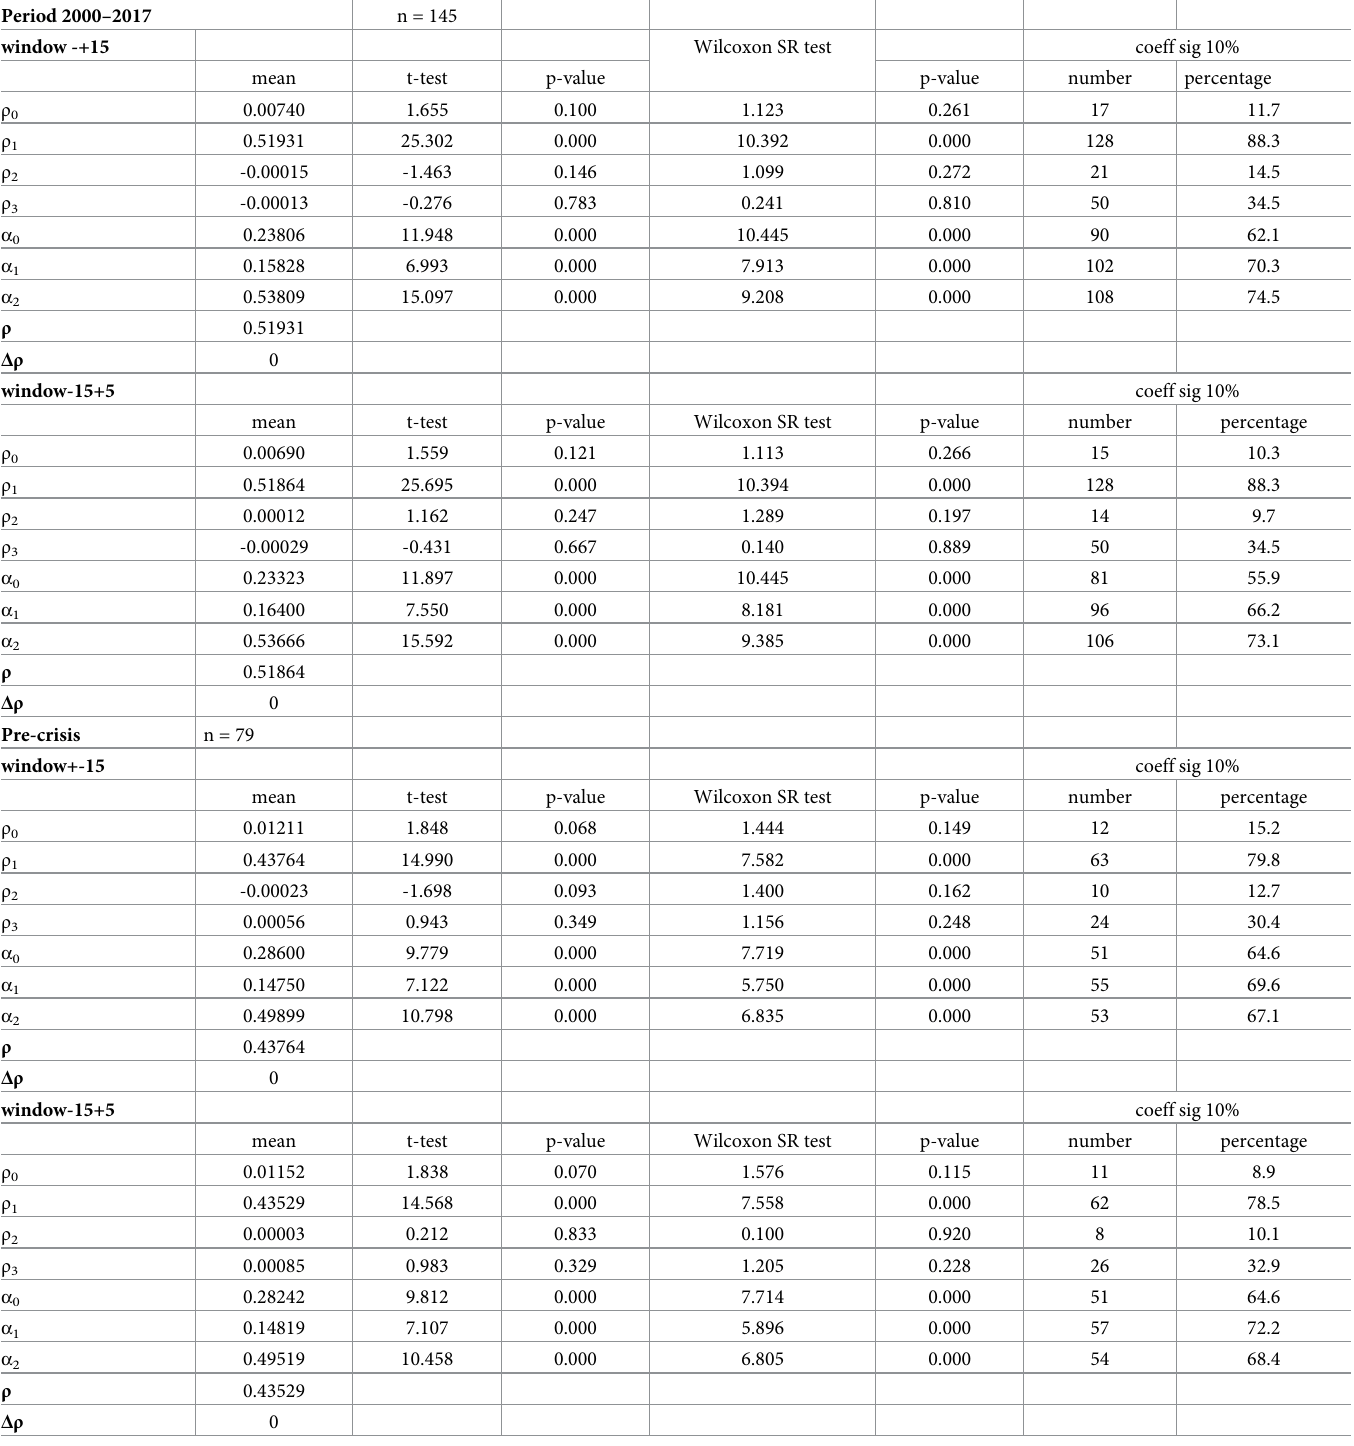
Table 10. Summary of results–normalized: